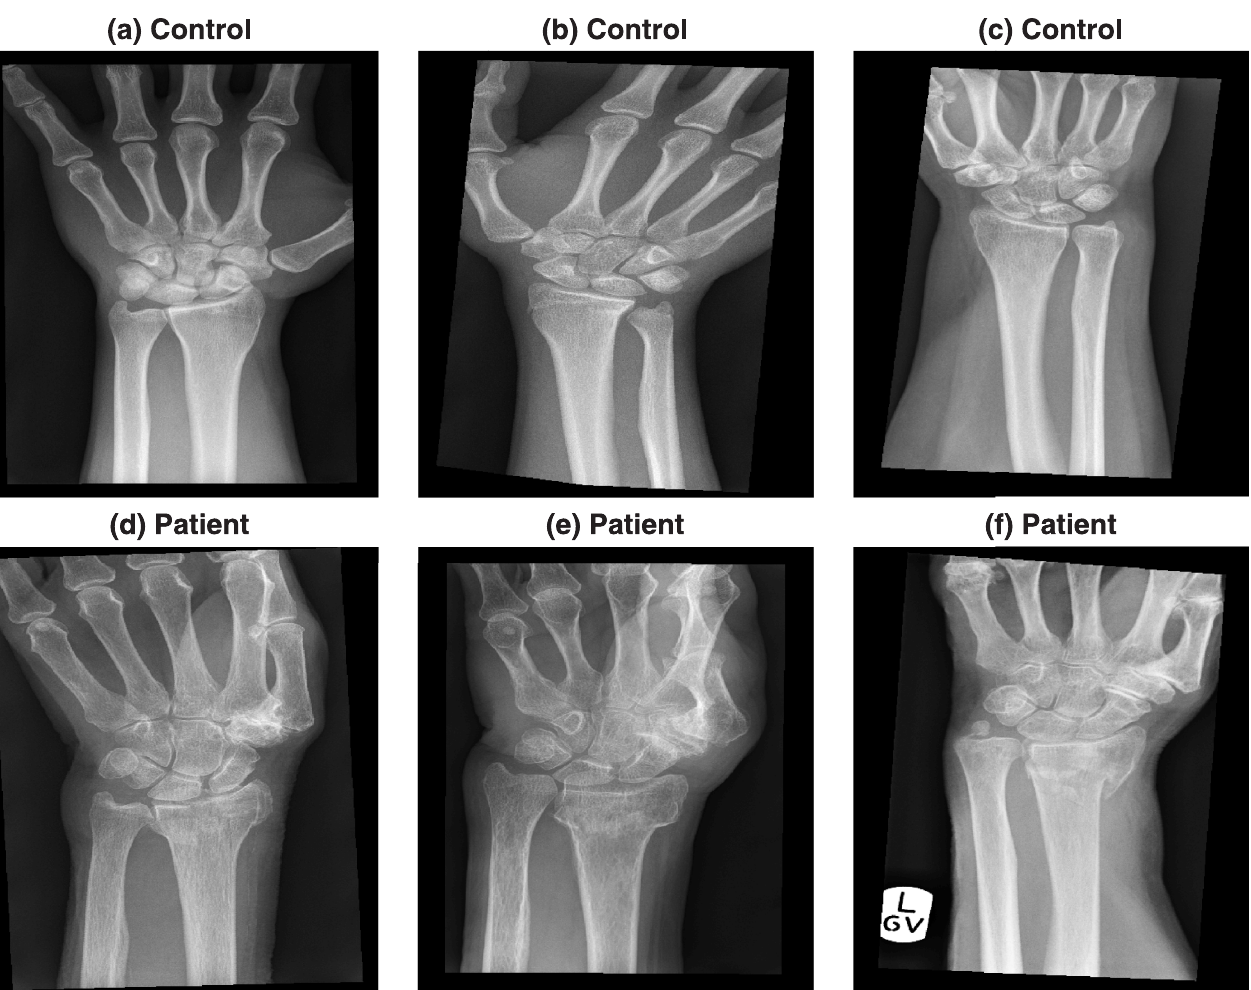
Fig 5. Outcome of the automatic pre-processing of the radiographs. The six representative cases shown in Fig 2 were automatically rotated so that the forearm is vertical. In addition, the artefacts due to the collimator were removed. All the code is written in Matlab and each image is pre-processed in less than one